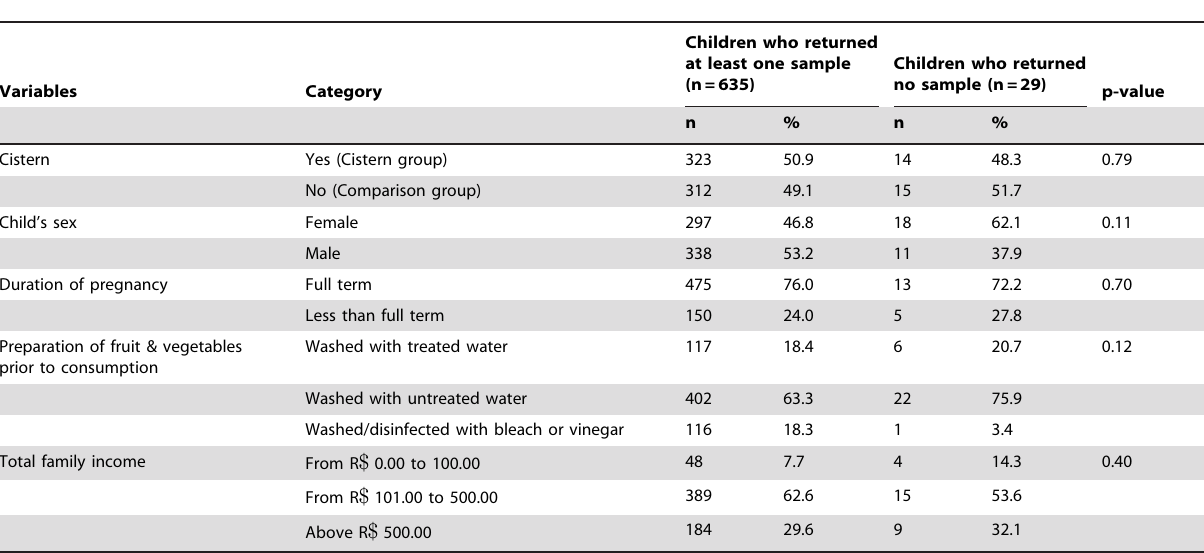
Table 2. Losses regarding the return of stool samples for parasitological